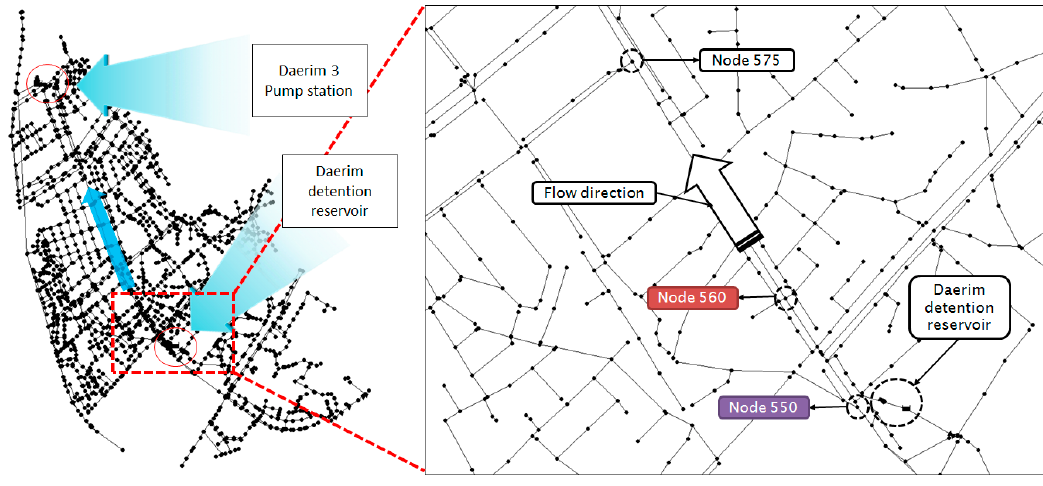
Figure 4. Location of the first and maximum flooding nodes in the main conduits.